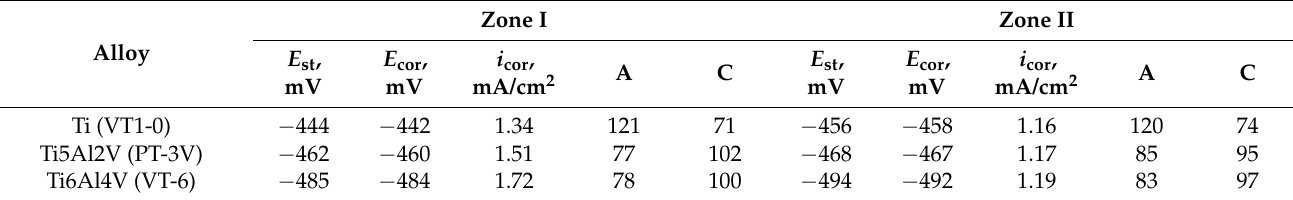
Table 3. Results of electrochemical corrosion tests of the Ti alloy